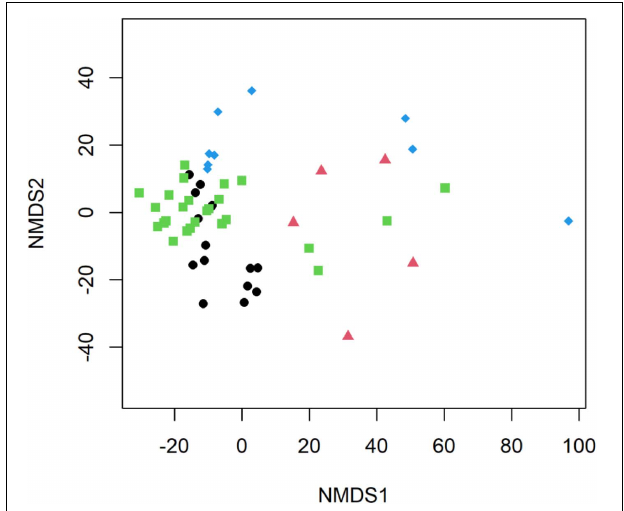
FIGURE 4 | Non-metric multidimensional scaling (NMDS) plot of E. coli , ARGs, and sewage-associated markers, measured in water samples ( n = 56) collected from peri-urban sites during baseflow (black circle) and stormflow (red triangle), as well as and urban sites during baseflow (green square) and stormflow (blue diamond) along the Brisbane River system, Brisbane,